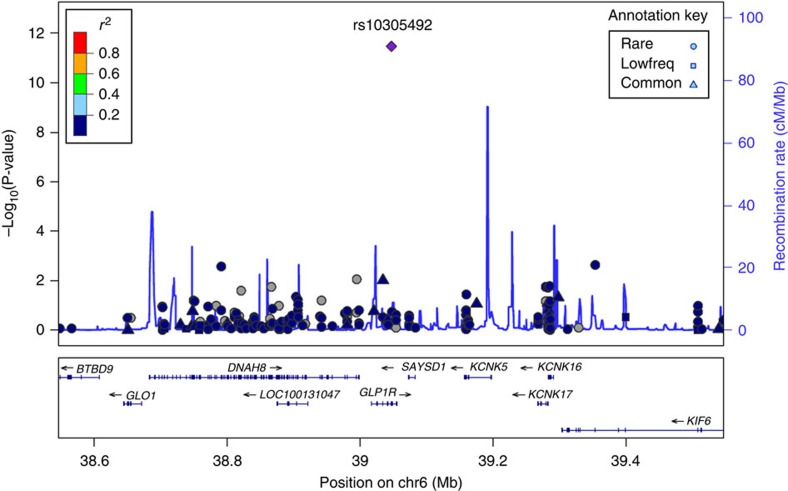
GLP1R regional association plot.Regional association results (−log10p) for fasting glucose of GLP1R locus on chromosome 6. Linkage disequilibrium (r2) indicated by colour scale legend. Triangle symbols indicate variants with MAF>5%, square symbols indicate variants with MAF1–5% and circle symbols indicate variants with MAF<1%.